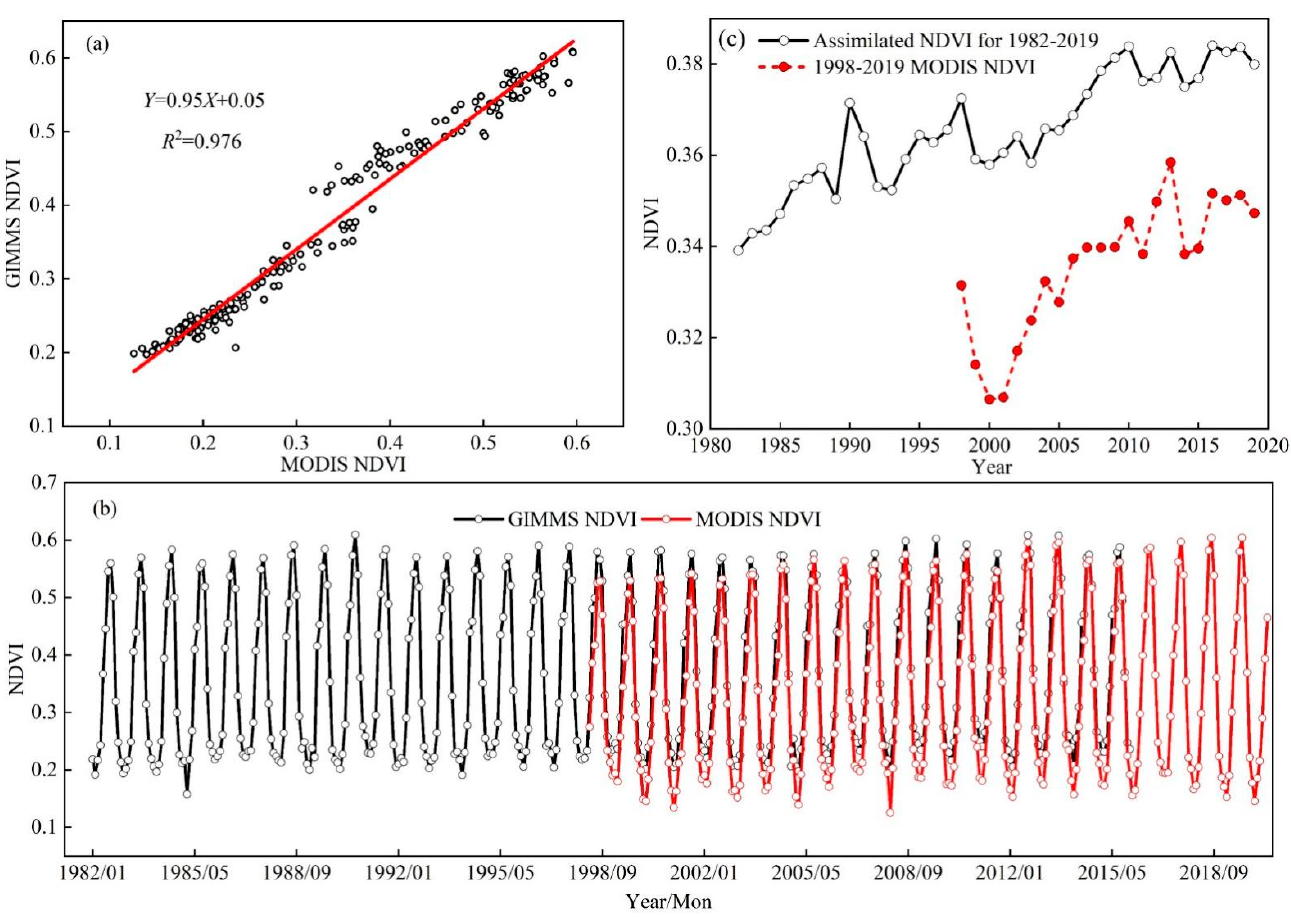
Figure 2. NDVI data preprocessing. ( a ) Correlation analysis between the GIMMS NDVI and the MODIS NDVI, ( b ) comparison of the GIMMS NDVI and the MODIS NDVI data sequences, and ( c ) comparison of assimilated NDVI and MODIS NDVI data. NDVI: normal difference vegetation index.